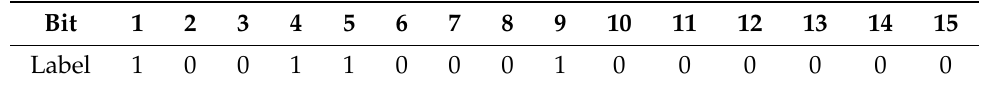
Table 5. Code representation of